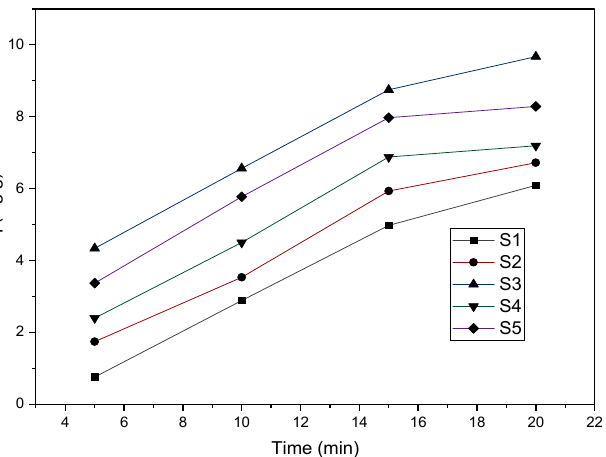
Figure 5. The effect of contact time on the adsorption of phenol at concentration of 75 mg/L and 100 mg .